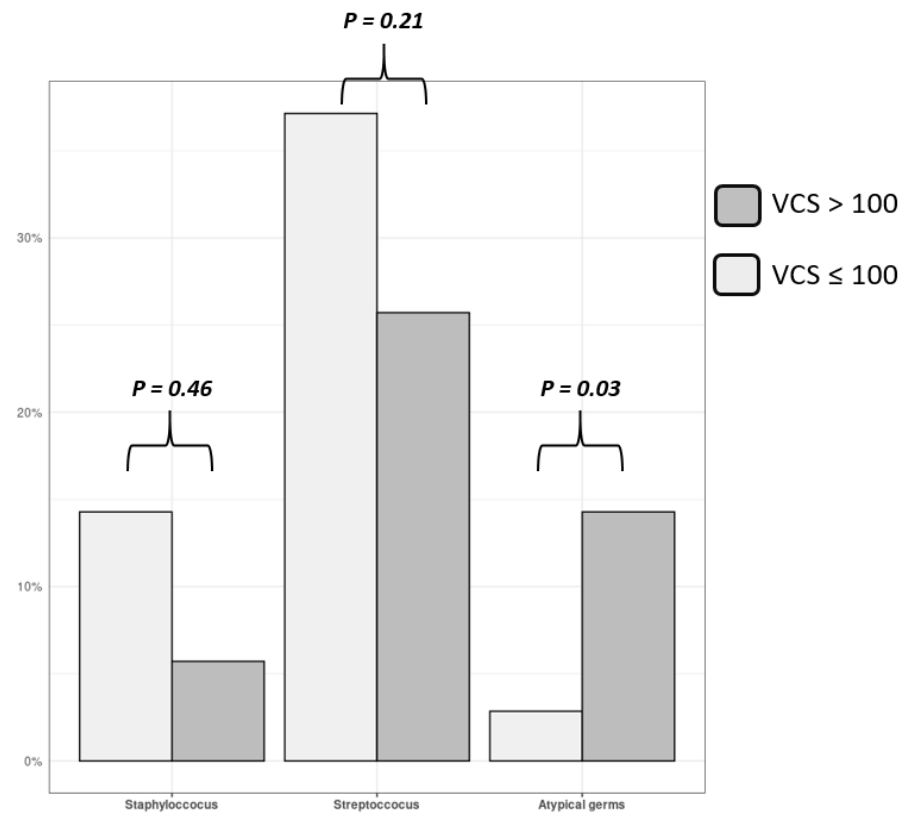
Figure 4. Germ’s type for aortic IE.